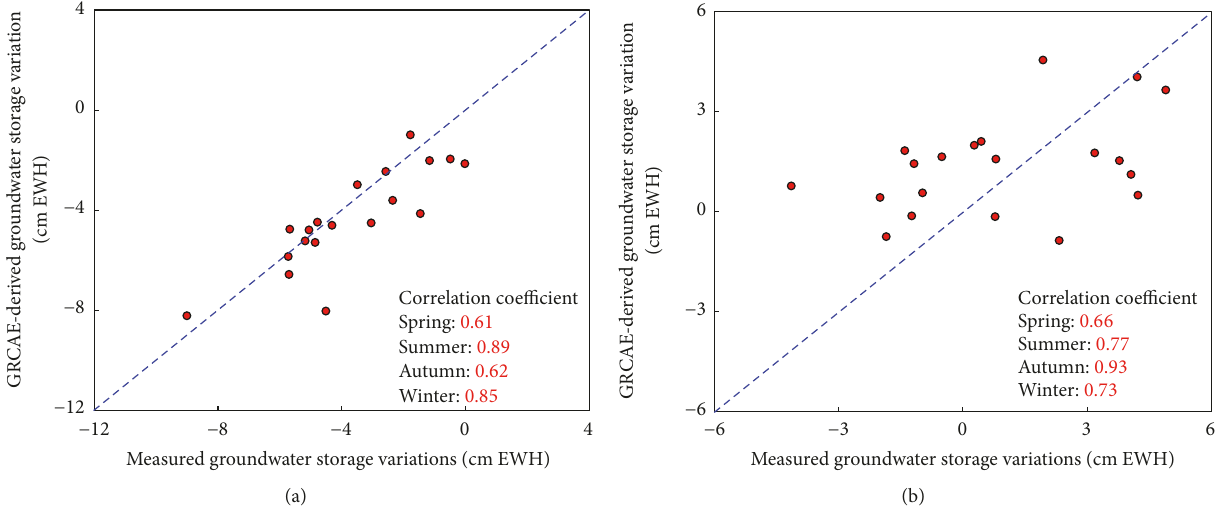
Figure 6: Comparison of the quarterly measured and derived GWS variations in (a) the Huang-Huai-Hai Plain and (b) the Song-Liao Plain.